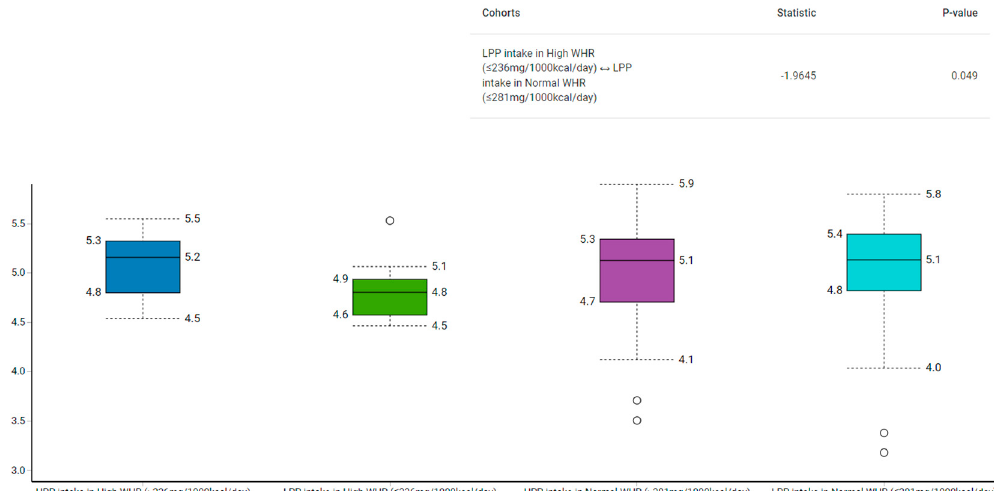
Figure 2. Comparison of gut microbiota α -diversity according to categories of polyphenol intake and relative to BMI using Shannon – Wiener Index. HPP, high polyphenols; LPP, low polyphenols.